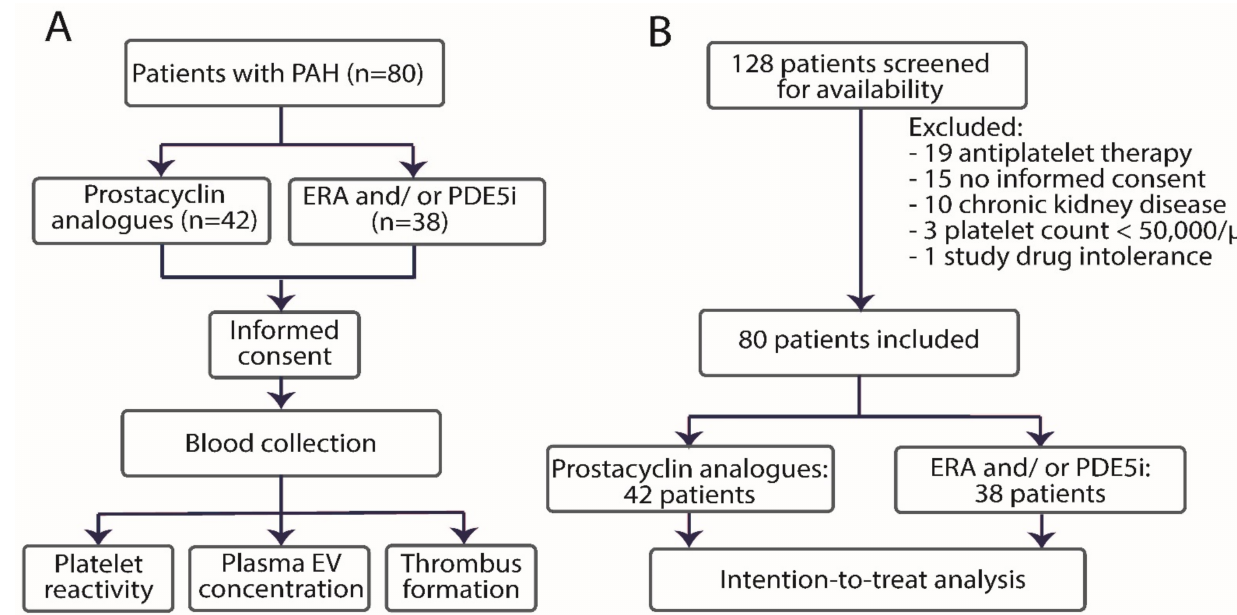
Figure 1. Trial schedule ( A ) and patients’ flow diagram ( B ). PAH—pulmonary arterial hypertension, ERA—endothelin receptor antagonists, PGE-5i—phosphodiesterase-5